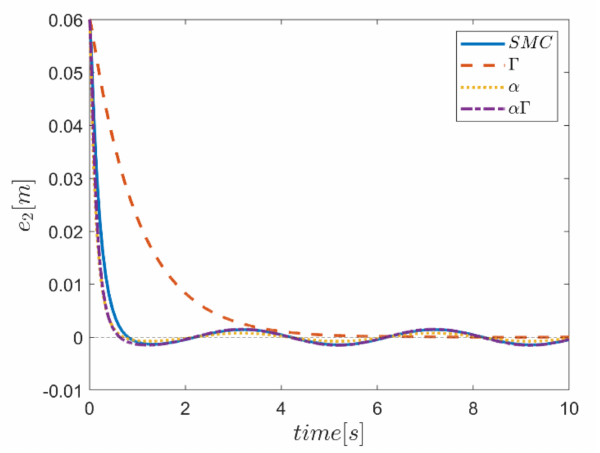
Figure 19. Tracking error in the y channel.